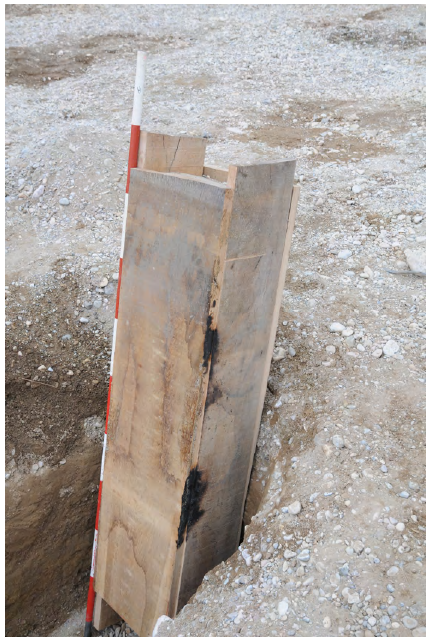
Figure 10: Experiment: Carbonization Marks on the “coffin” in “grave 902” (photo: Judith